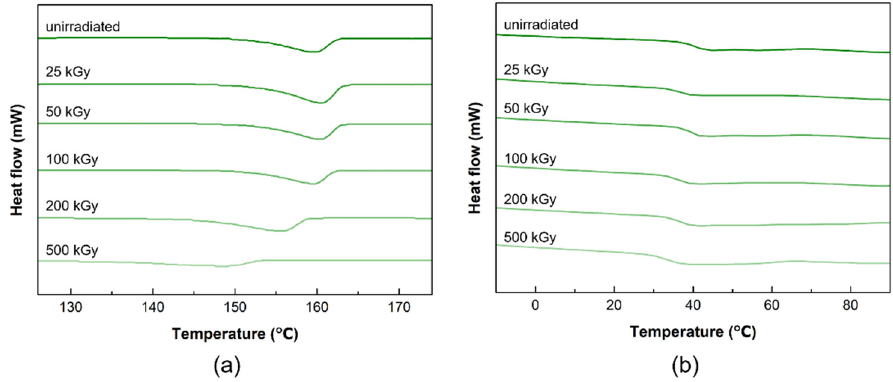
Figure 4. DSC thermograms of the before and after gamma-ray irradiation ( a ) PLCL and ( b ) PLDLA polymer films.